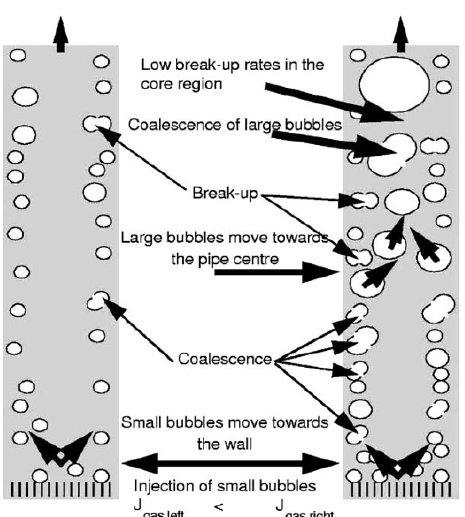
Figure 3. Flow regimes and regime transitions in a large-diameter bubble column. Reprinted with permission from [7].